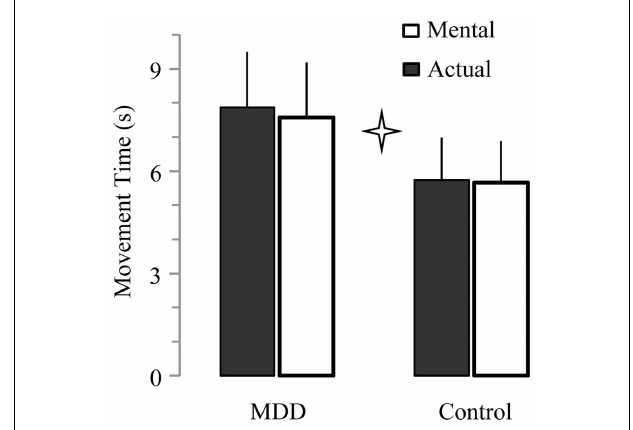
FIGURE 2 |Average ( ± SD) values of actual and mental movement times for both groups . Star indicates significant differences between groups ( P < 0.001).